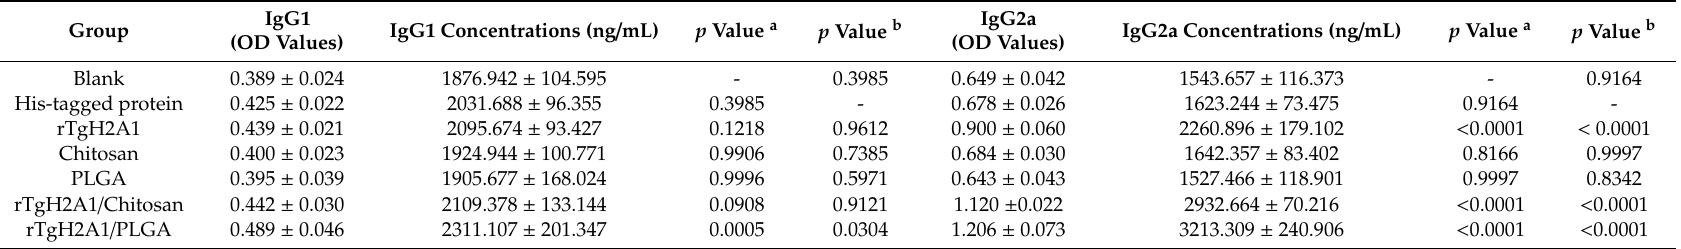
a and b were compared with the blank group and his-tagged protein group,